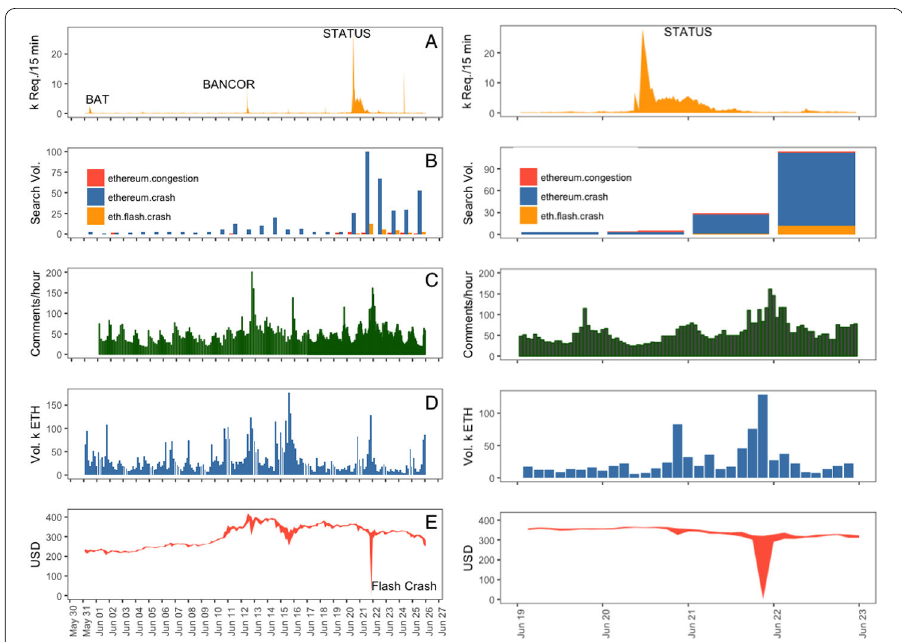
Figure 2 Dynamics of different interdependent systems Left : ( A ) Raw number of transaction requests (in thousands) to the Ethereum network (specifically, through myetherwallet.com) over time, with notable peaks corresponding to some well known ICOs. ( B ) Search volume of Google queries related to congestion and crash of the Ethereum system. ( C ) Number of comments per hour on Reddit about Ethereum ( D ) Volume of “ethers” (in thousands) traded on GDAX. ( E ) Low and high values of ethers exchanged for US dollars on GDAX (data from cryptocompare.com). Right: details around the Flash Crash